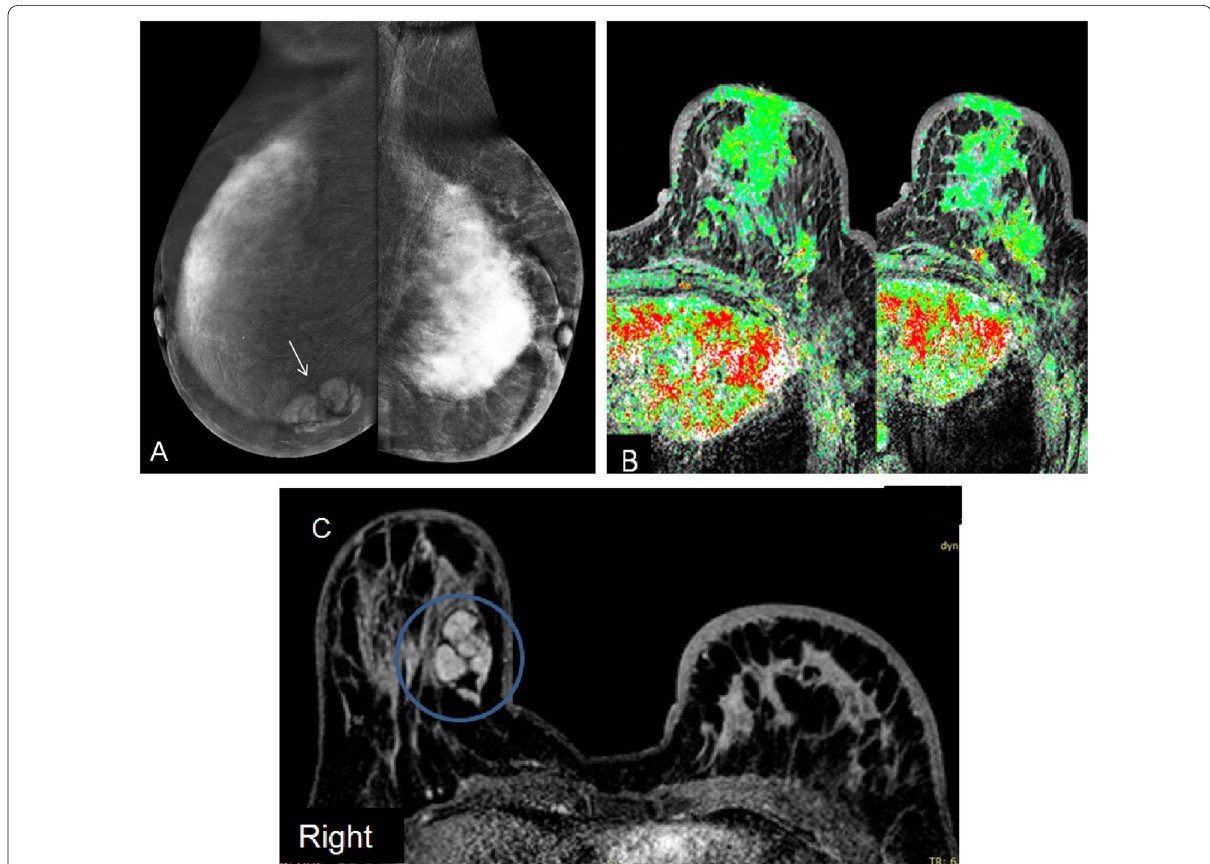
Fig. 5 Bilateral breast lesions; right fibroadenoma and left locally advanced carcinoma. a Bilateral CEM medio-lateral views that showed right breast lower inner mass of oval shape, circumscribed borders and dark internal septations (arrow) and left breast regional asymmetrical non-mass enhancement of clumped enhancement pattern. b Color mapping post-contrast MR image that showed malignant-looking soft tissue infiltration of the left breast. c Post-contrast MR image that displayed right breast mass with characteristics of fibroadenoma. CEM and post-contrast MR images showed comparable morphology descriptors for both benign and malignant breast